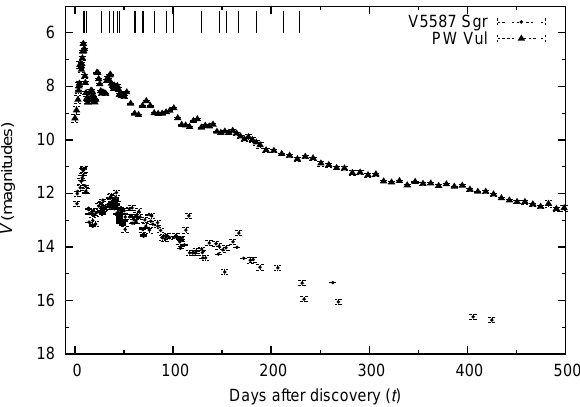
Figure 1: V band magnitudes of V5587 Sgr and PW Vul. The light curve of V5587 Sgr is from Higashi- Hiroshima Observatory, VSNET, and AAVSO observa- tions. The light curve of PW Vul was refer to the online data of Strope et